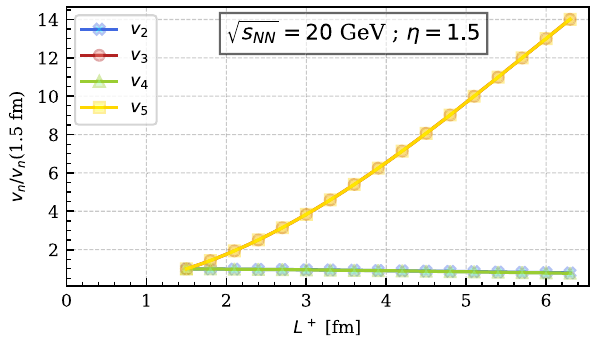
+ ) + . The odd harmonics increase v n ( 1 . 5 fm ) with L